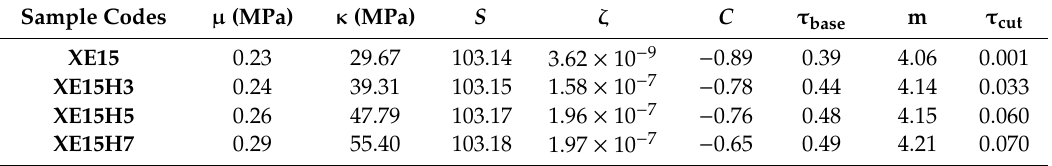
Figure 6. Young’s modulus at 300% elongation for various XNBR/epoxy/XHNTs nanocomposites. Table 3. Material model parameters for various XNBR / epoxy / XHNTs nanocomposites. Sample